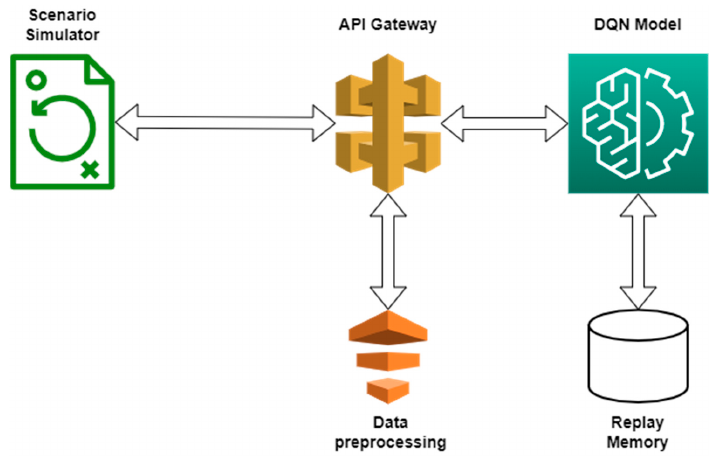
Figure 3. DQN Algorithm Workflow.